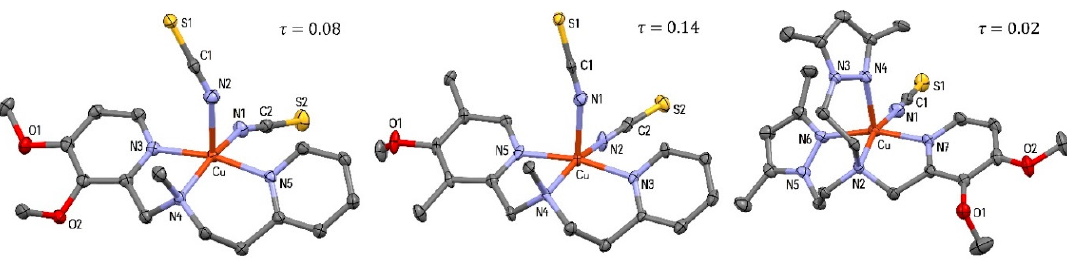
Figure 1. Perspective views of 1 ( left ), 2 ( center ) and complex cation of 5 ( right ). θ and φ bond angles (°) used for calculation of τ -values: 1 : N3-Cu-N5 167.20(3); N1-Cu-N4 162.13(9); 2 : N3-Cu-N5 168.4(3), N2-Cu-N4 160.3(3); and 5 : N6-Cu-N7 163.94(12), N1-Cu-N2 162.46(12).